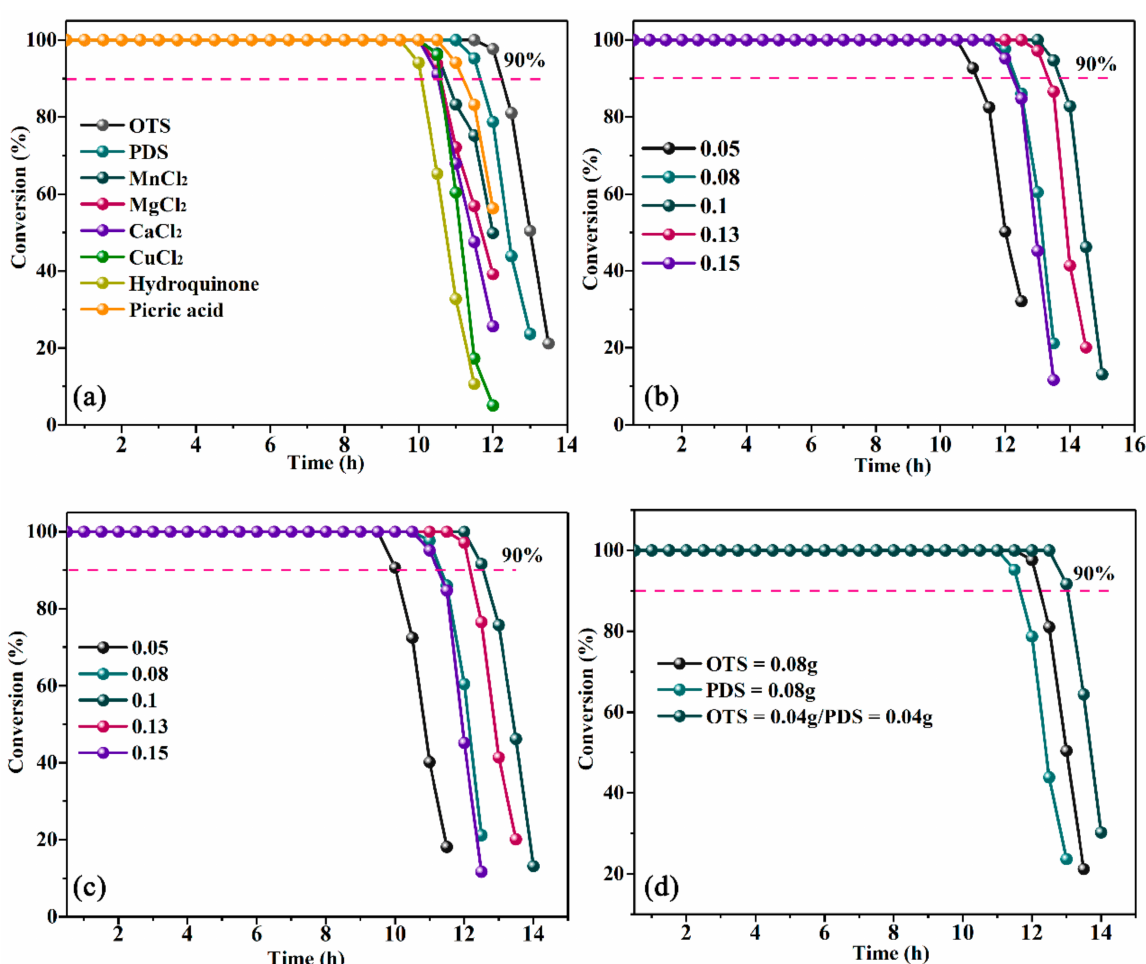
Figure 3. The effect of different additives in desulfurization efficiency: ( a ) various additive, ( b ) the effect of content of OTS: 0.05–0.15 g, ( c ) the effect of content of PDS: 0.05–0.15 g, ( d ) the effect of co-addition of OTS and